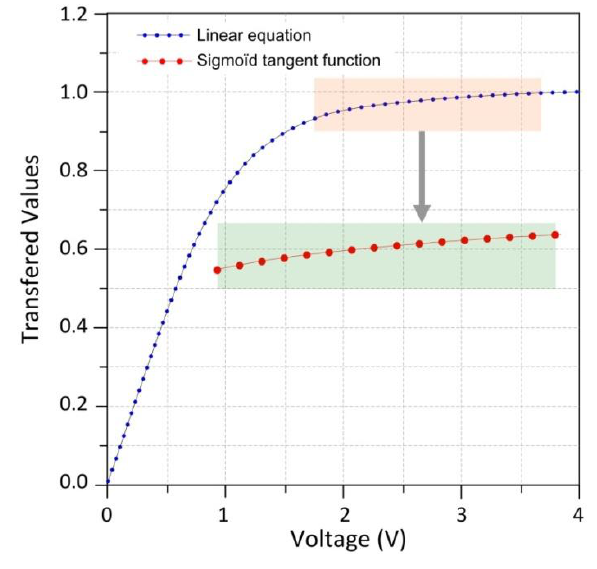
Figure 11. Comparison of sigmoid tangent and linear